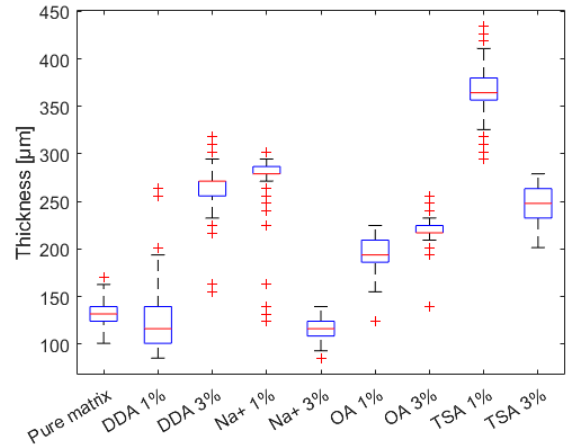
Figure 13. Distribution of the sample thickness.